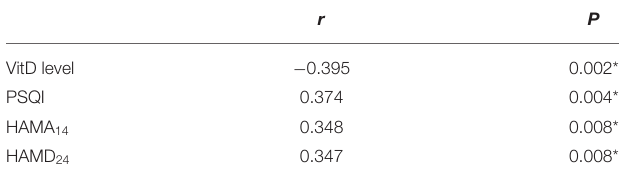
TABLE 4 | Pearson correlation analysis of IRLSSG score with serum VitD level and various scale scores.